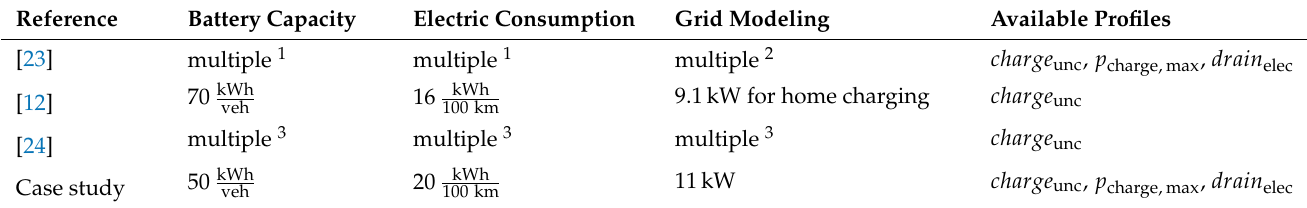
Table 5. Literature studies calculating electric vehicle fleet profiles and respective assumptions